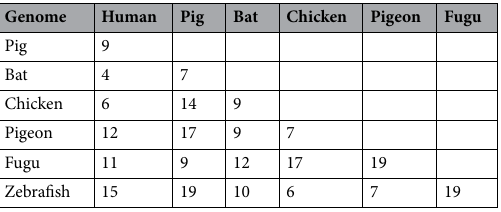
Table 2. Comparison of vertebrate heatmaps. The number of differences in third nucleotide bias (color, not magnitude) between heatmaps for the genomes of various vertebrates are